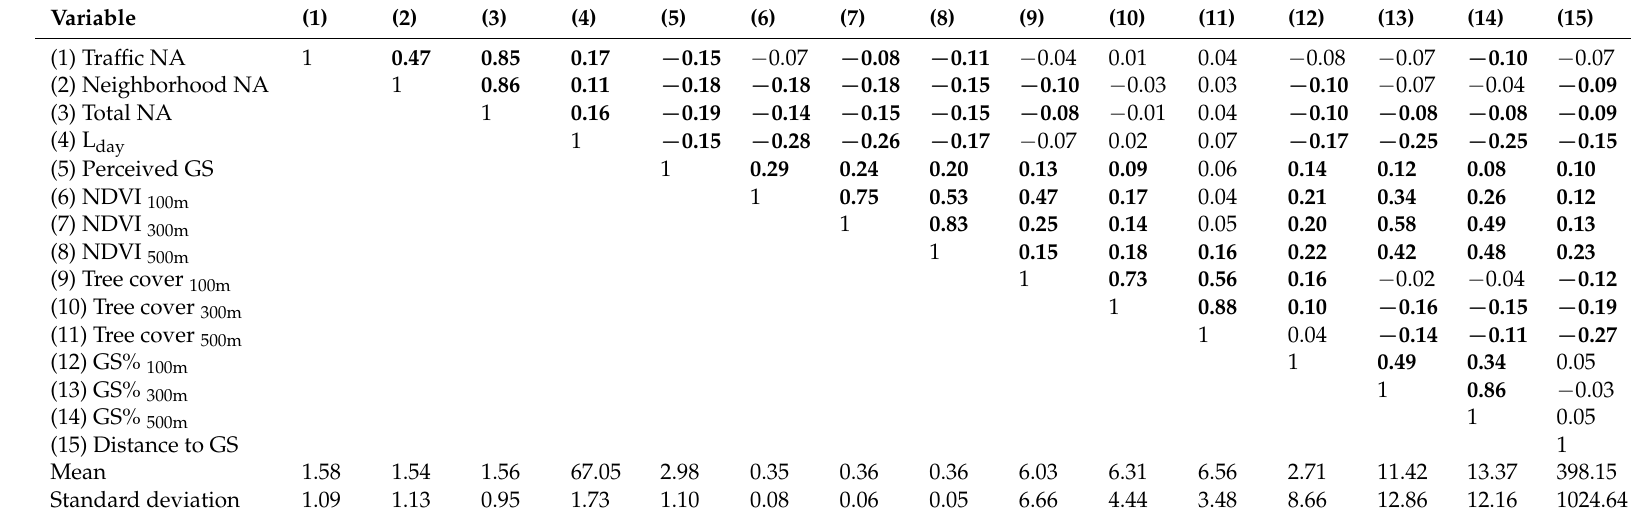
Table 1. Pearson correlations of the main variables in the analysis ( N =